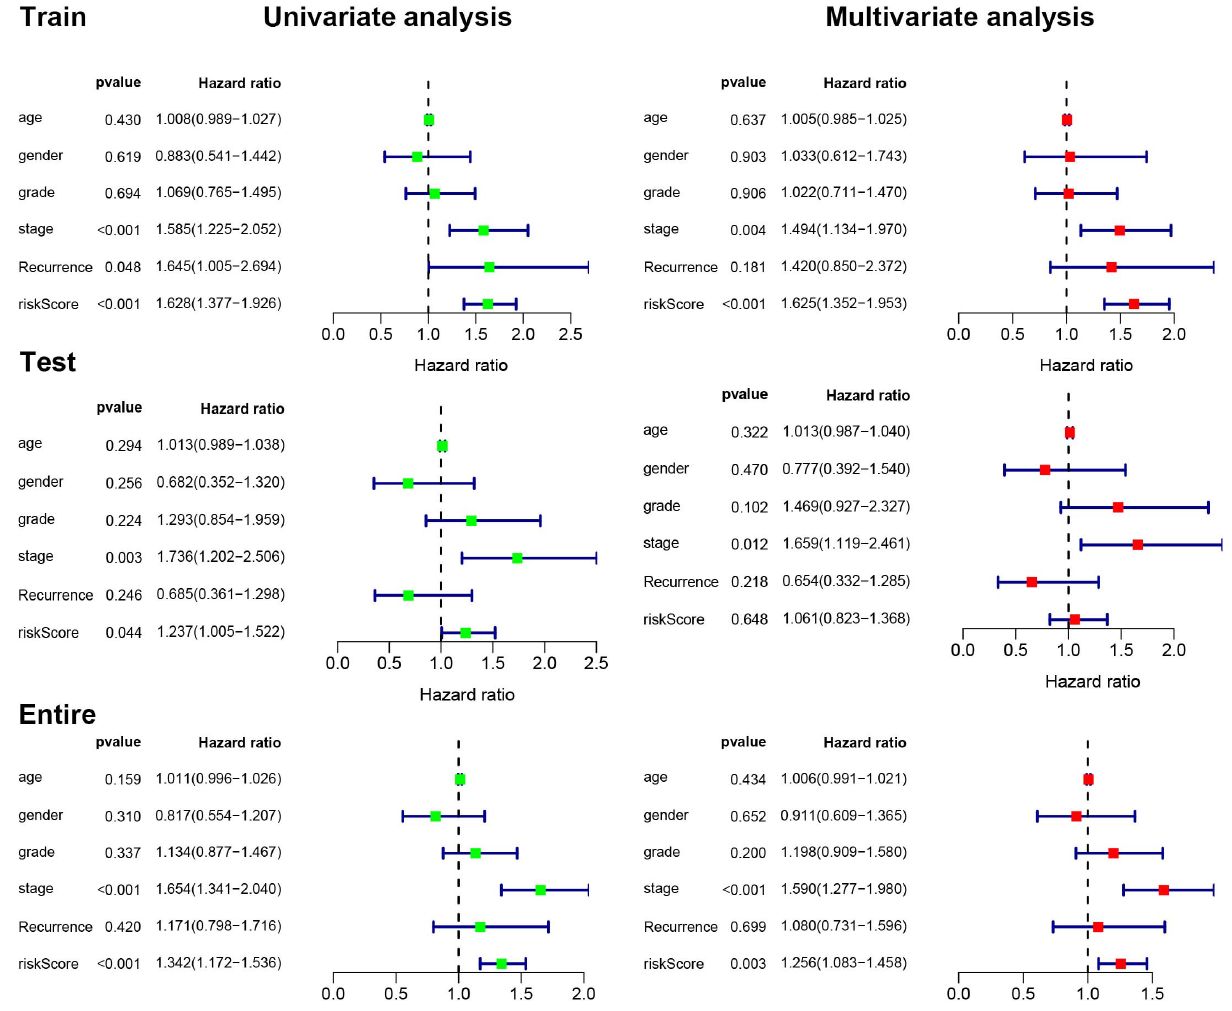
FIGURE 4 | Univariate and multivariate Cox regression analyses. Univariate and multivariate Cox regression analyses illustrated the clinical features within the training, testing, and entire